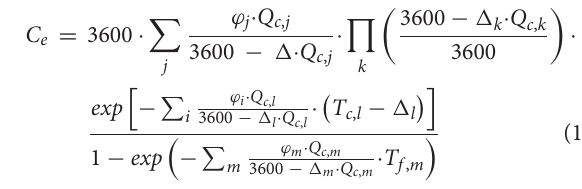
driving lines. The semicircles meet at the translation axis